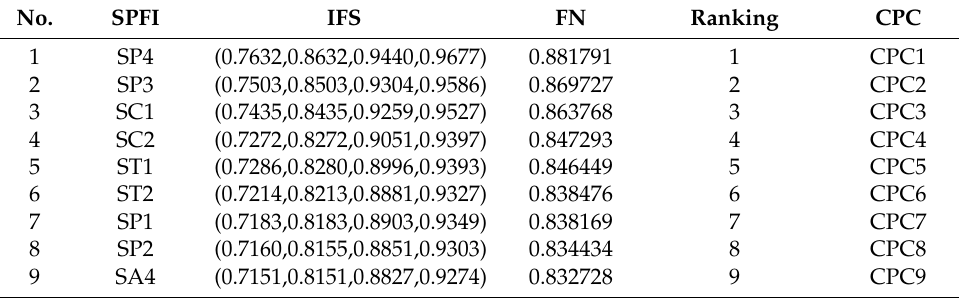
Table 8. Top nine ranked safety philosophical factors’ indicator